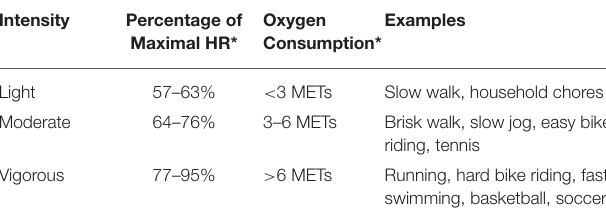
TABLE 1 | Exercise